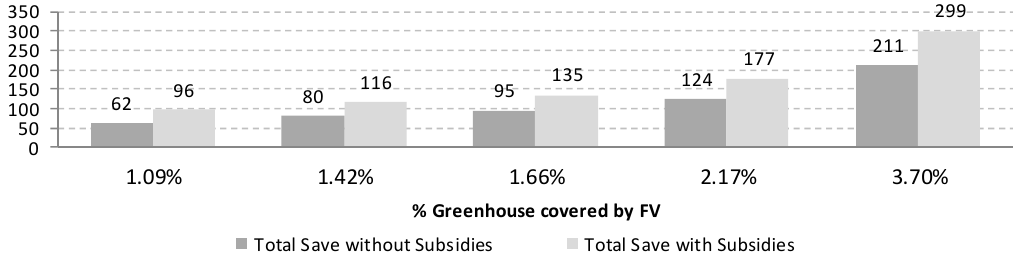
Figure 11. Savings (million € ) in horticultural sector in southeast Spain using PV systems.